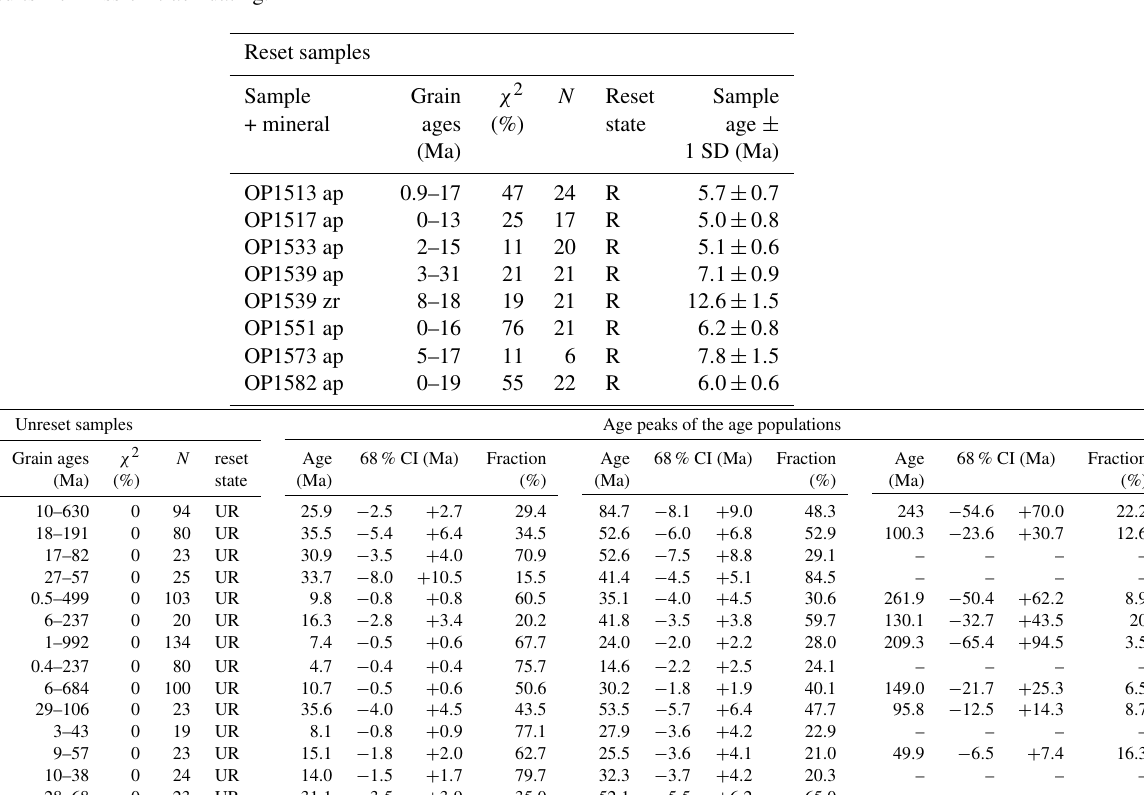
Table 3. Results from fission-track dating.